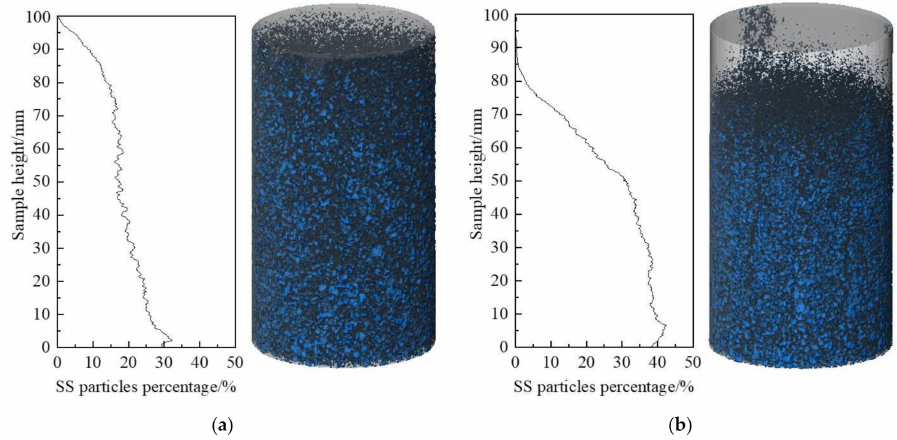
Figure 7. Distribution law of SS particles at different heights. ( a ) Gypsum: 10 wt. %, FA: 50 wt. % and SS: 40 wt. %; ( b ) Gypsum: 10 wt. %, FA: 40 wt. % and SS: 50 wt.